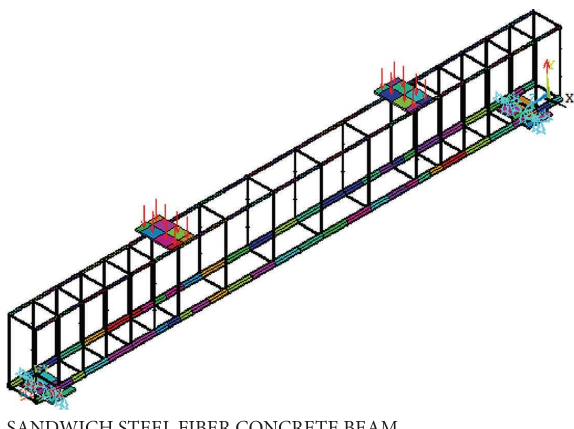
Figure 13: Te distance between the stirrups at the ends of the beam has been increased to